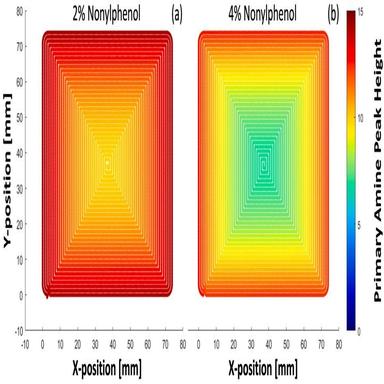
Map of amine peak height as a function of position during printing of an Epon 828/MXD system with 2% (a) and 4% nonylphenol (b).